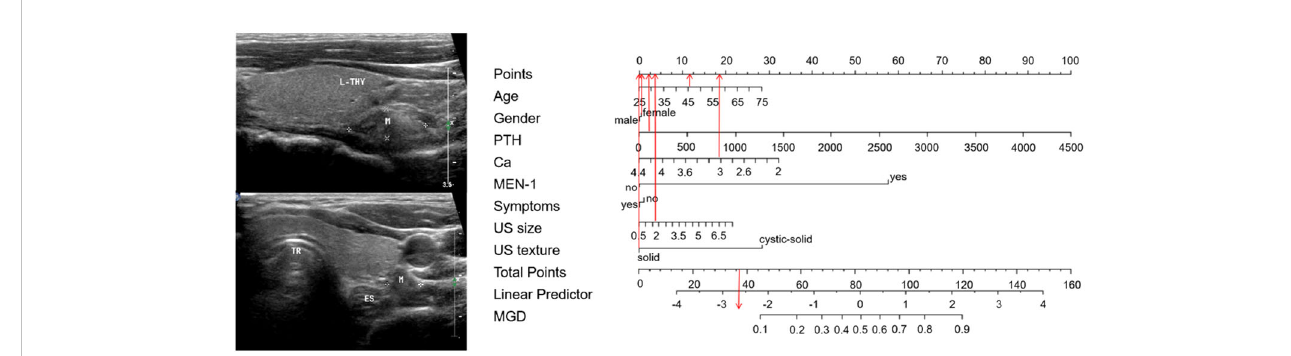
FIGURE 5 Examples of clinical use the nomogram for SGD. A 46-year-old man with PHPT complained recurrent urinary stones. The PTH and serum calcium level were 201 pg/ml and 3.08mmol/L respectively. MEN-1 was not diagnosed. The neck ultrasound showed 1.7cm-sized solid nodule in his left lower parathyroid area. The total score is 37, which corresponds to an MGD risk of less than 0.10. Pathology con fi rmed that the PHPT patients with SGD (a hyperplasia). Abbreviations:. L-THY=left thyroid, M=mass, TR=trachea, ES=esophagus.